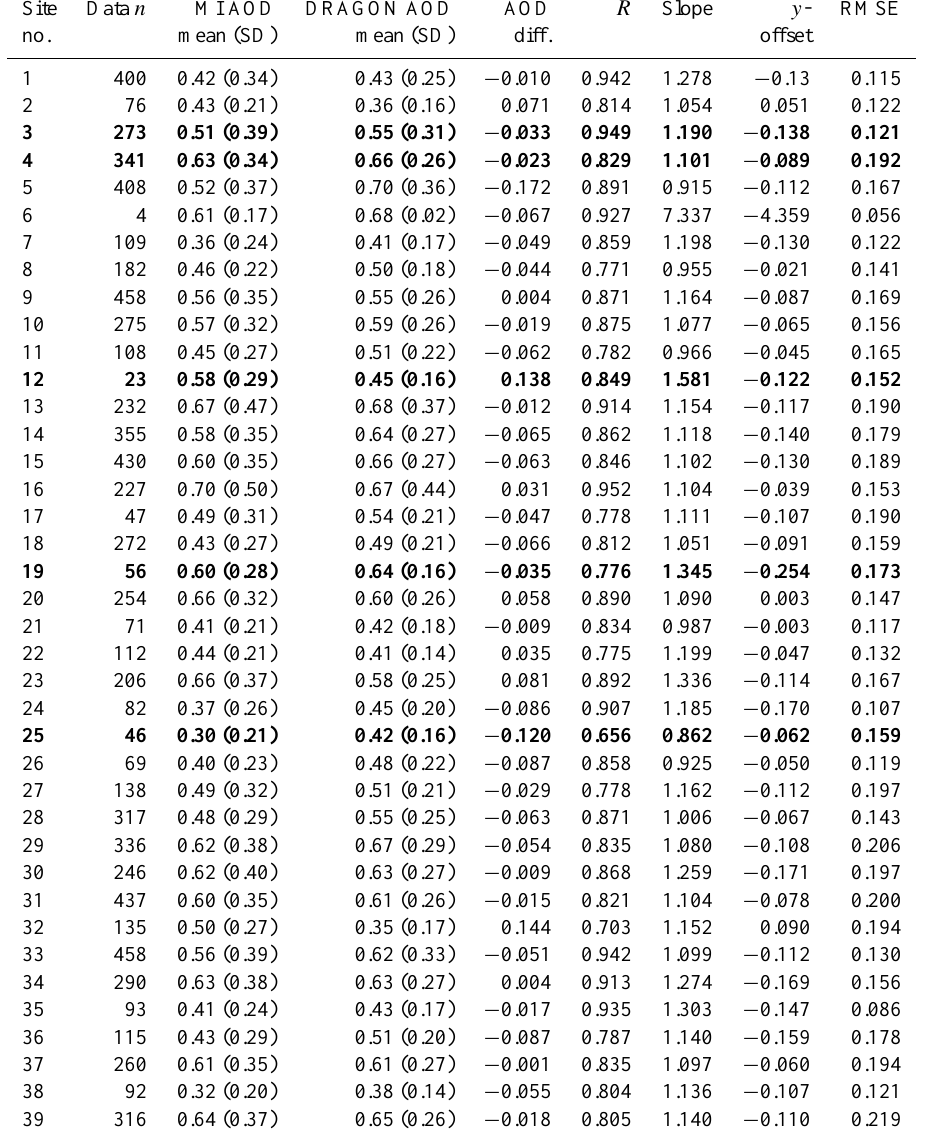
Table 3. Summary statistics of the comparison between the MI AOD (550nm) retrieved with the original LUT and AERONET AOD (550nm). The site numbers correspond to the numbers listed in Table 1 and Fig. 9a. The sites mentioned in Sect. 4.2 are represented by bold